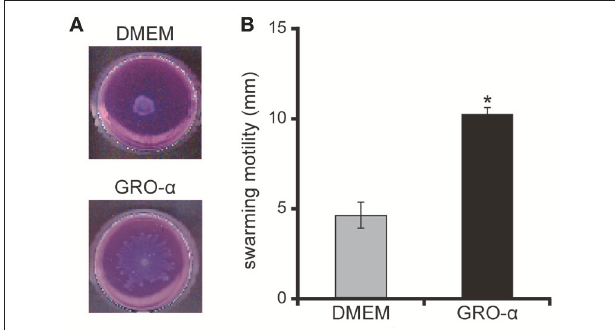
FIGURE 9 | GRO- α does not attract the P. aeruginosa PAO1 strain. (A) A glass slide was filled with the GFP-expressing P. aeruginosa PAO1 strain. A capillary tube was filled with growth regulated oncogene- α or Dulbecco’s modified Eagle medium (DMEM; control). The accumulation of P. aeruginosa at the capillary tip was visualized and photographed by microscopy at a magnification of 40 × . (B) The graph shows the relative intensity of GFP in the capillary tube after incubation for 10 min. Error bars indicate standard error ( n =